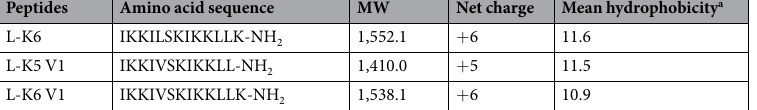
Table 1. Amino acid sequences and physical characteristics of L-K6 and its analogues. a The mean hydrophobicity values of the peptides were calculated using the hydrophobicity scales and were represented as the total hydrophobicity (sum of all residue hydrophobicity indices) divided by the number of residues. All residue hydrophobicity indices were defined as follows: Trp, 32.4; Phe, 29.1; Leu, 23.3; Ile, 21.4; Met, 15.7; Tyr, 14.7; Val, 13.4; Pro, 9.0; Cys, 7.6; Lys, 2.8; Glu, 2.8; Ala, 2.8; Thr, 2.3; Asp, 1.6; Arg, 0.6; Gln, 0.6; His, 0; Ser, 0; Gly, 0; and Asn, −